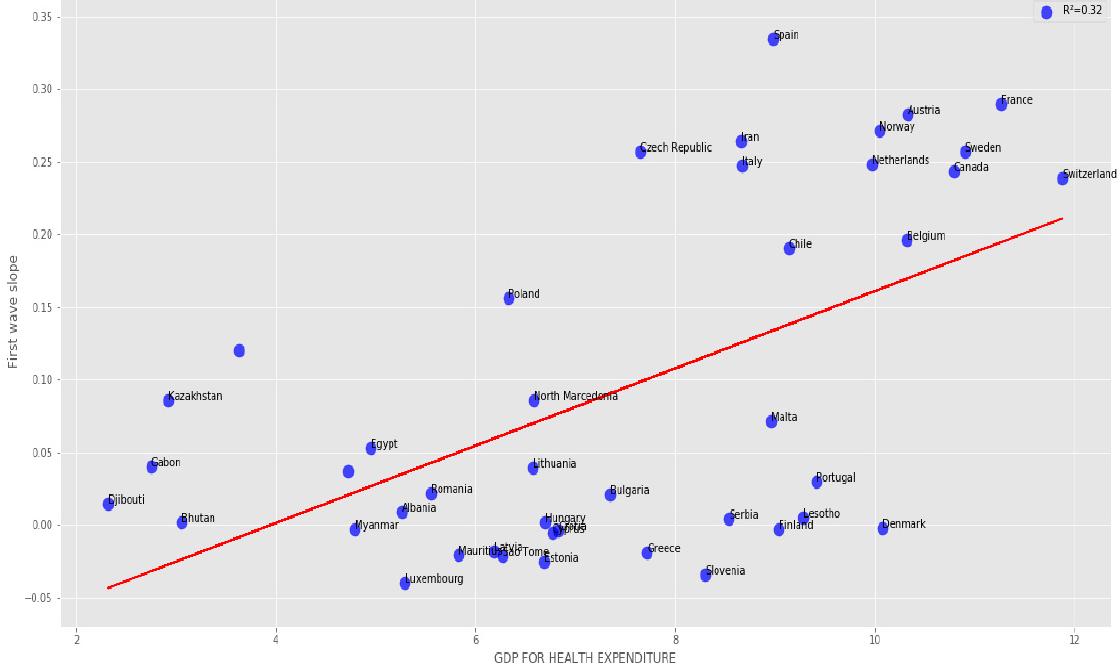
Figure 4. Regression plot of first wave exponential regression slope vs CHE/GDP for developed and developing countries. LinregressResult slope = 0.026632, intercept = − 0.1052912, r value = 0.5661, p value = 7.60 × 10 − 5 , stderr = 0.00605655, R-squared = 0.320470, RMSE for linear regression = 0.095836.